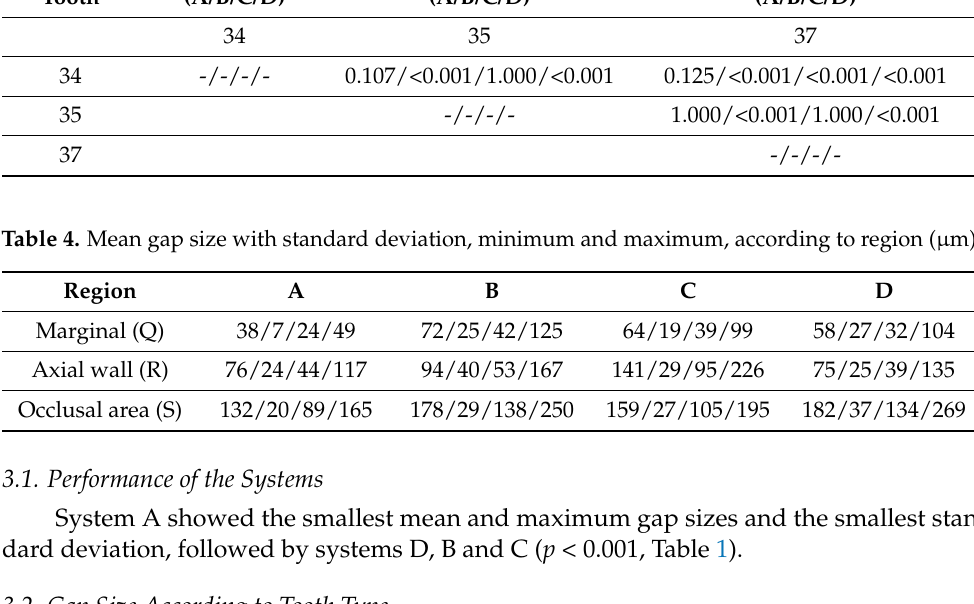
Table 3. Repeated-measures one-way analysis of variance results. Tooth